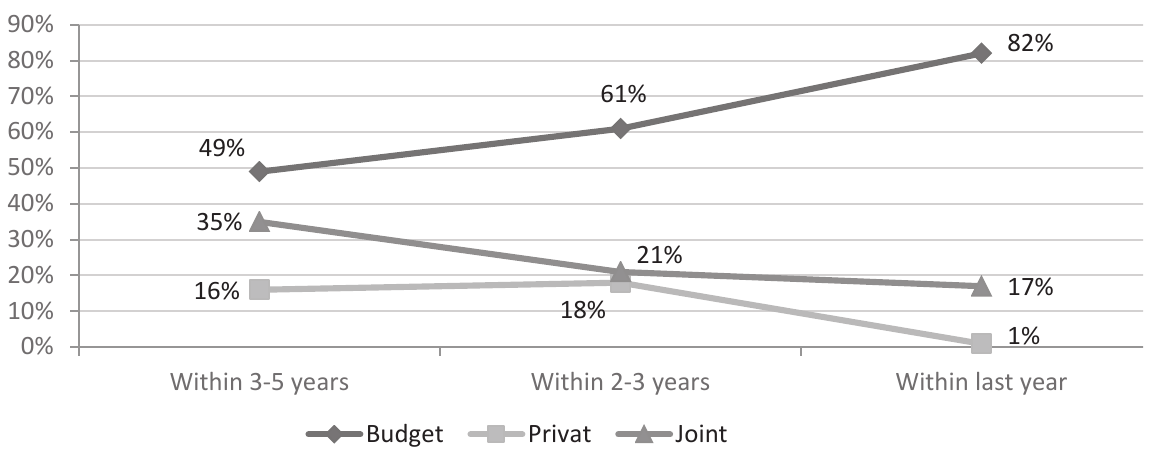
Figure 4. Trends in the distribution of investments in the communal infrastructure (by source)